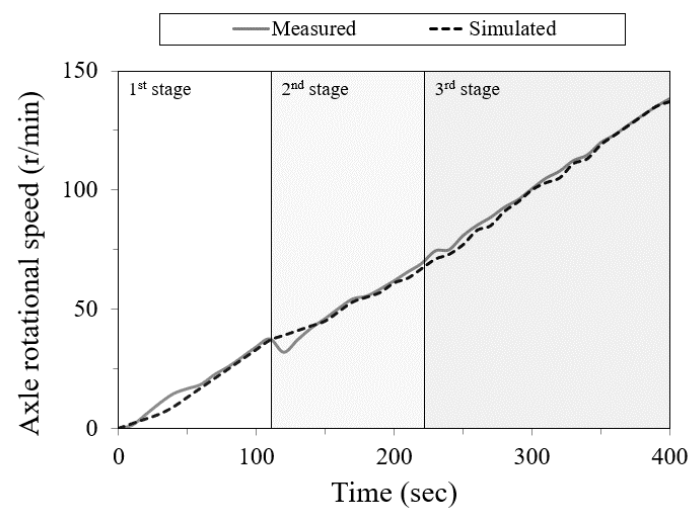
Figure 8. Comparison of axle rotational speed of the HMT for the measured and simulated results according to the gear stages. Table 4. Comparison of the axle rotational speed between the measured and simulation results based on the gear